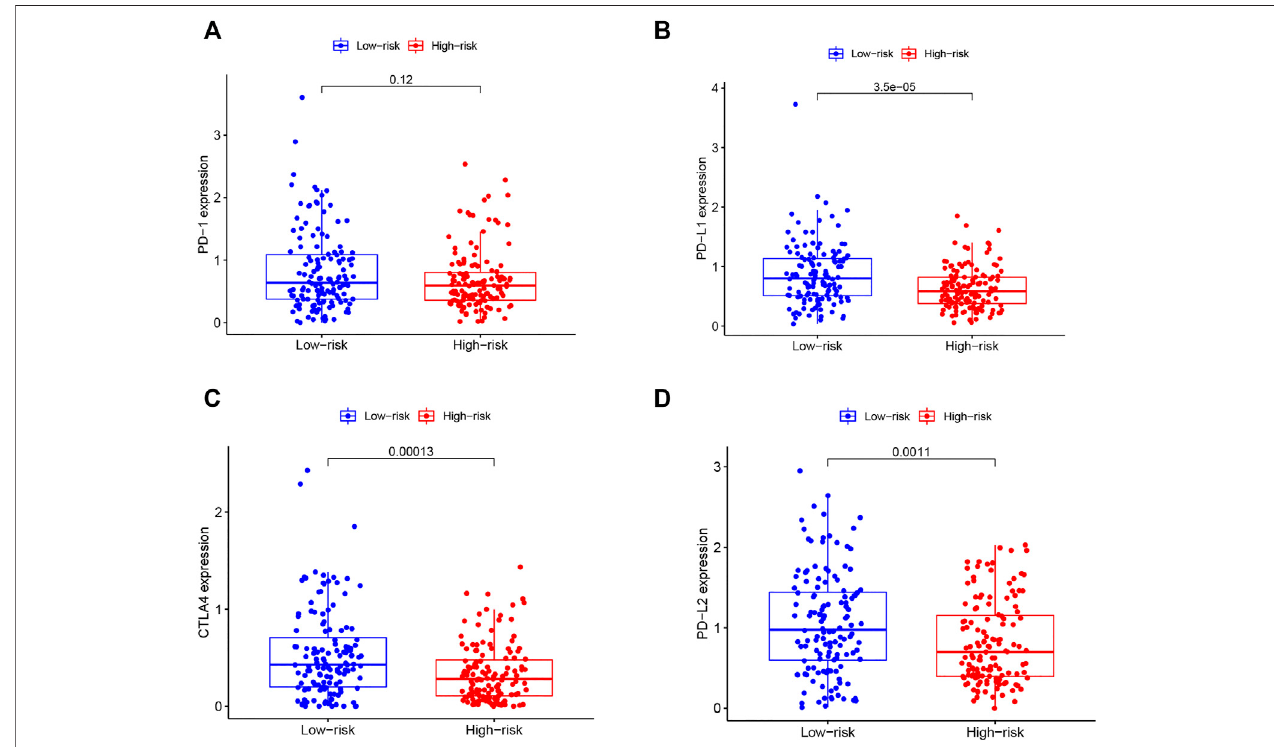
FIGURE 6 | Correlation of immune checkpoint molecules with risk score (A – D) boxplots of PD1, PDL1, CTLA4, PD-L2 expression of OC patients in high and low-risk groups.